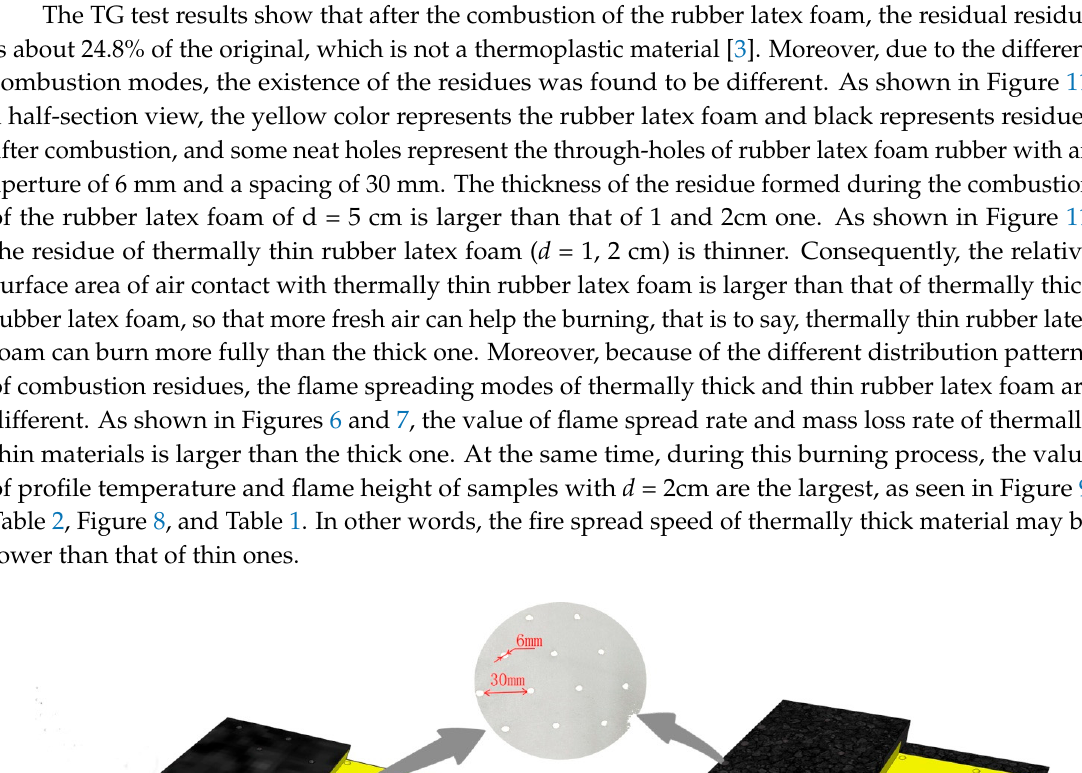
Figure 10. Fire spread mechanism of thermally thick and thermally thin materials.